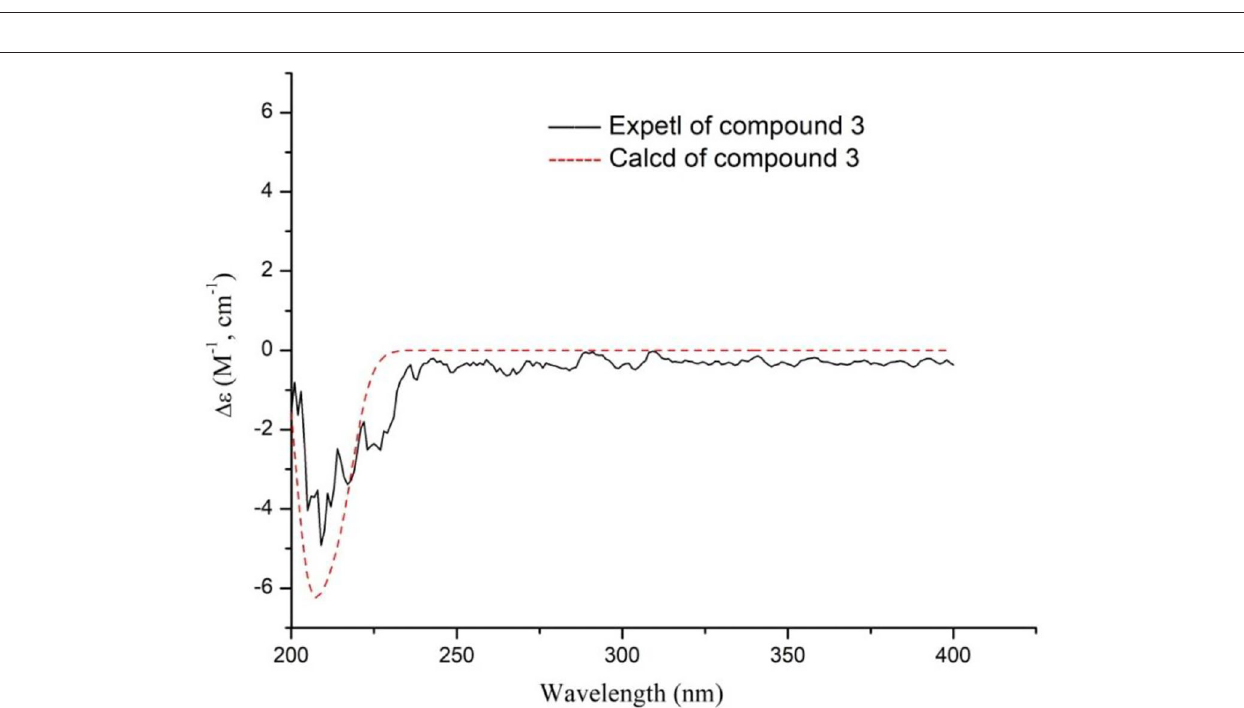
FIGURE 7 | Calculated and experimental ECD spectra of compound 3 at TDDFT/B3LYP/6-31G(d) level.